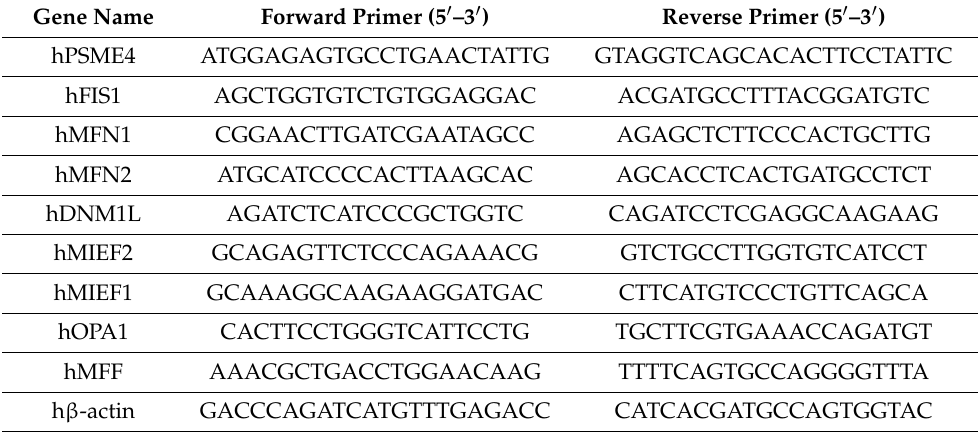
Table 1. Primers used in this